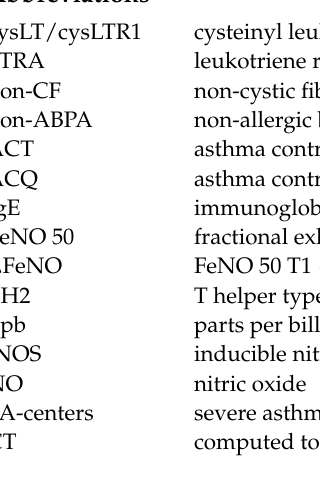
therapy intake; Table S2: Baseline comparison based on ∆ FeNO 50 of Patients’ characteristics, comor- bidities related to asthma, radiological severity of bronchiectasis, type of biological therapy